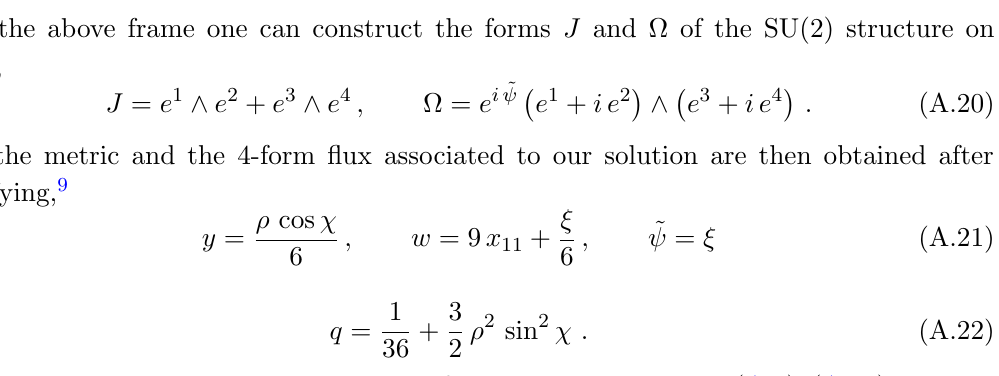
Figure 7 . Circular quiver associated to the Abelian T-dual solution and corresponding brane set- up. There are N 4 D4-branes stretched between the NS5 and NS5’ branes. NS5 and NS5’-branes are represented by transversal black and red dashed lines,